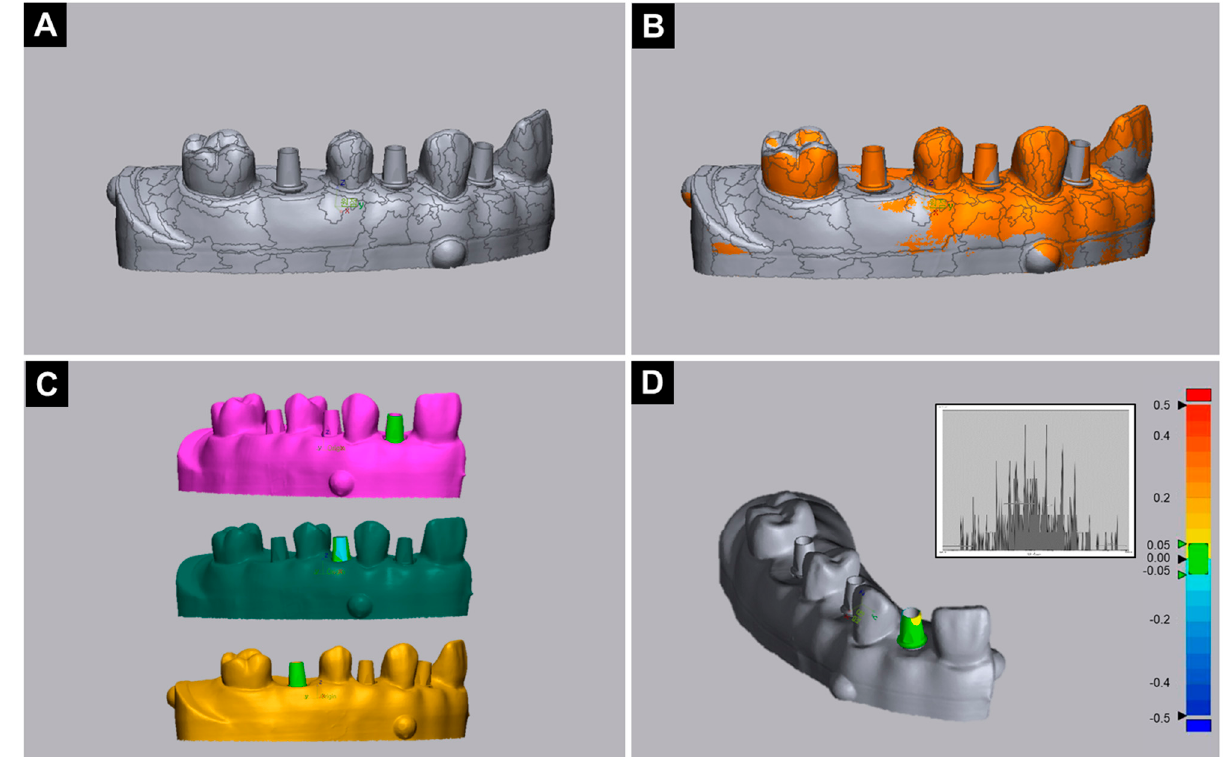
Figure 5. The process of analyzing the position of the replaced implant abutment in three dimensions: ( A ) After loading the reference data, the abutment regions were divided using an auto segmentation tool; ( B ) Alignment of the reference data and comparison data in an optimal position using a best-fit algorithm; ( C ) The process of analyzing the three different positions of the abutment in three dimensions; ( D ) Displaying the 3D analysis results as a color map.